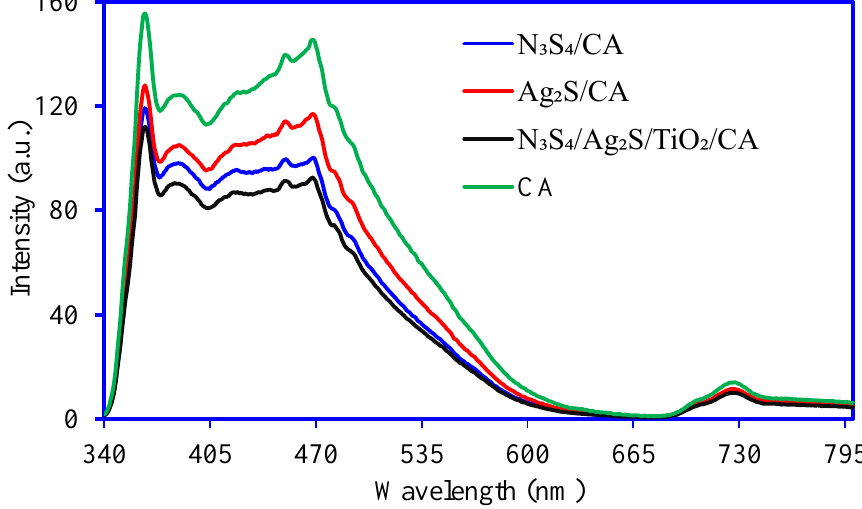
Figure 6. PL emission spectra of CA, Ni 3 S 4 /CA, Ag 2 S/CA, and Ni 3 S 4 /Ag 2 S/TiO 2 /CA. The elemental composition of Ni 3 S 4 /Ag 2 S/TiO 2 /CA studied by XPS as presented in Figure 7 showed the presence of C1s, O1s, Ti2p, Ni2p, Ag3d, Ca2p and S2p peaks corre- sponding to the presence of oxygen (48.1%), carbon (38.1%), titanium (7.6%), calcium (2.6%), nickel (2.4%), silver (0.9%), and sulfur (0.3%). The C1s spectra can be deconvoluted